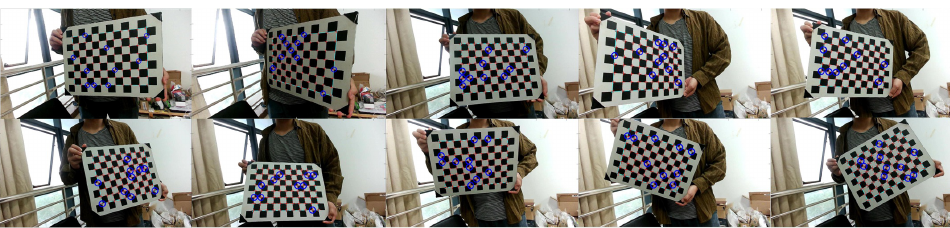
Figure 13. Ten images of the calibration plate at different distances and attitudes and the reprojec- tion effects. Table 4. Mean error ( mean err ) and median errors ( med err ) of reprojection coordinate points in 10 im- ages of the calibration plate at different distances and attitudes (unit: